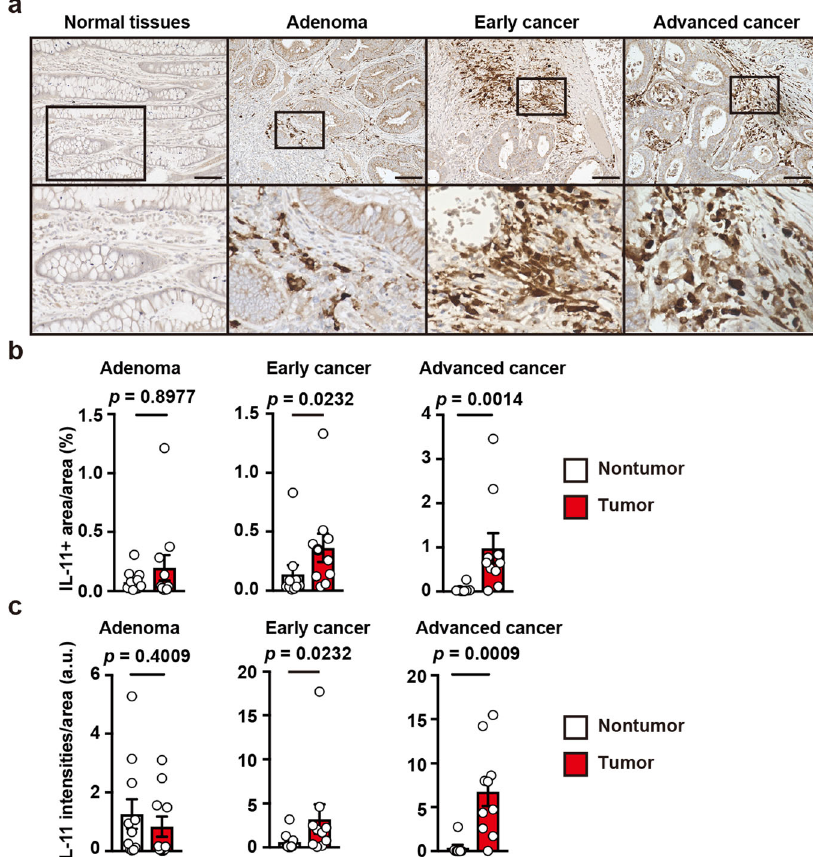
Fig. 9 IL-11 expression is correlated with progression of human cancers. a – c Adenomas ( n = 11) and early ( n = 10) and advanced ( n = 10) colorectal cancers were stained with anti-IL-11 antibody ( a ). Representative staining of the respective tumors and adjacent normal tissues. Scale bars, 100 μ m. IL-11 + area and total area were calculated and the percentages of IL-11 + area per area are plotted ( b ). The intensities of IL-11 + signals and total area were calculated and intensities of IL-11 + per area are expressed as arbitrary units (a.u.) ( c ). Results are mean ± SEM. n = 11 (adenoma), 10 (early cancer), 8 (nontumor, advanced cancer), or 10 (tumor, advanced cancer). Scale bars, 100 μ m. Statistical signi fi cance was determined using the two-sided Mann – Whitney U test ( b , c ). Source data are provided as a Source Data fi